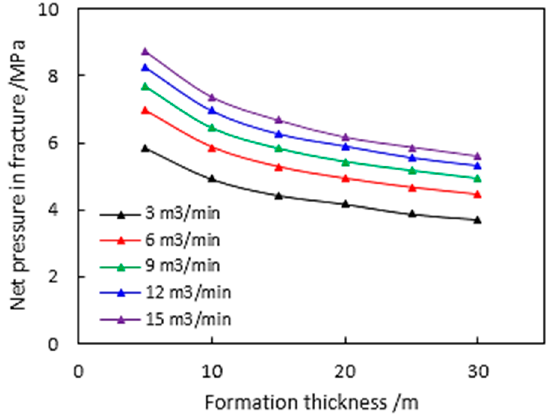
Figure 16. Variation of net pressures in formed fractures with the change of injection rate in formation layers with different thickness during fracturing treatments.